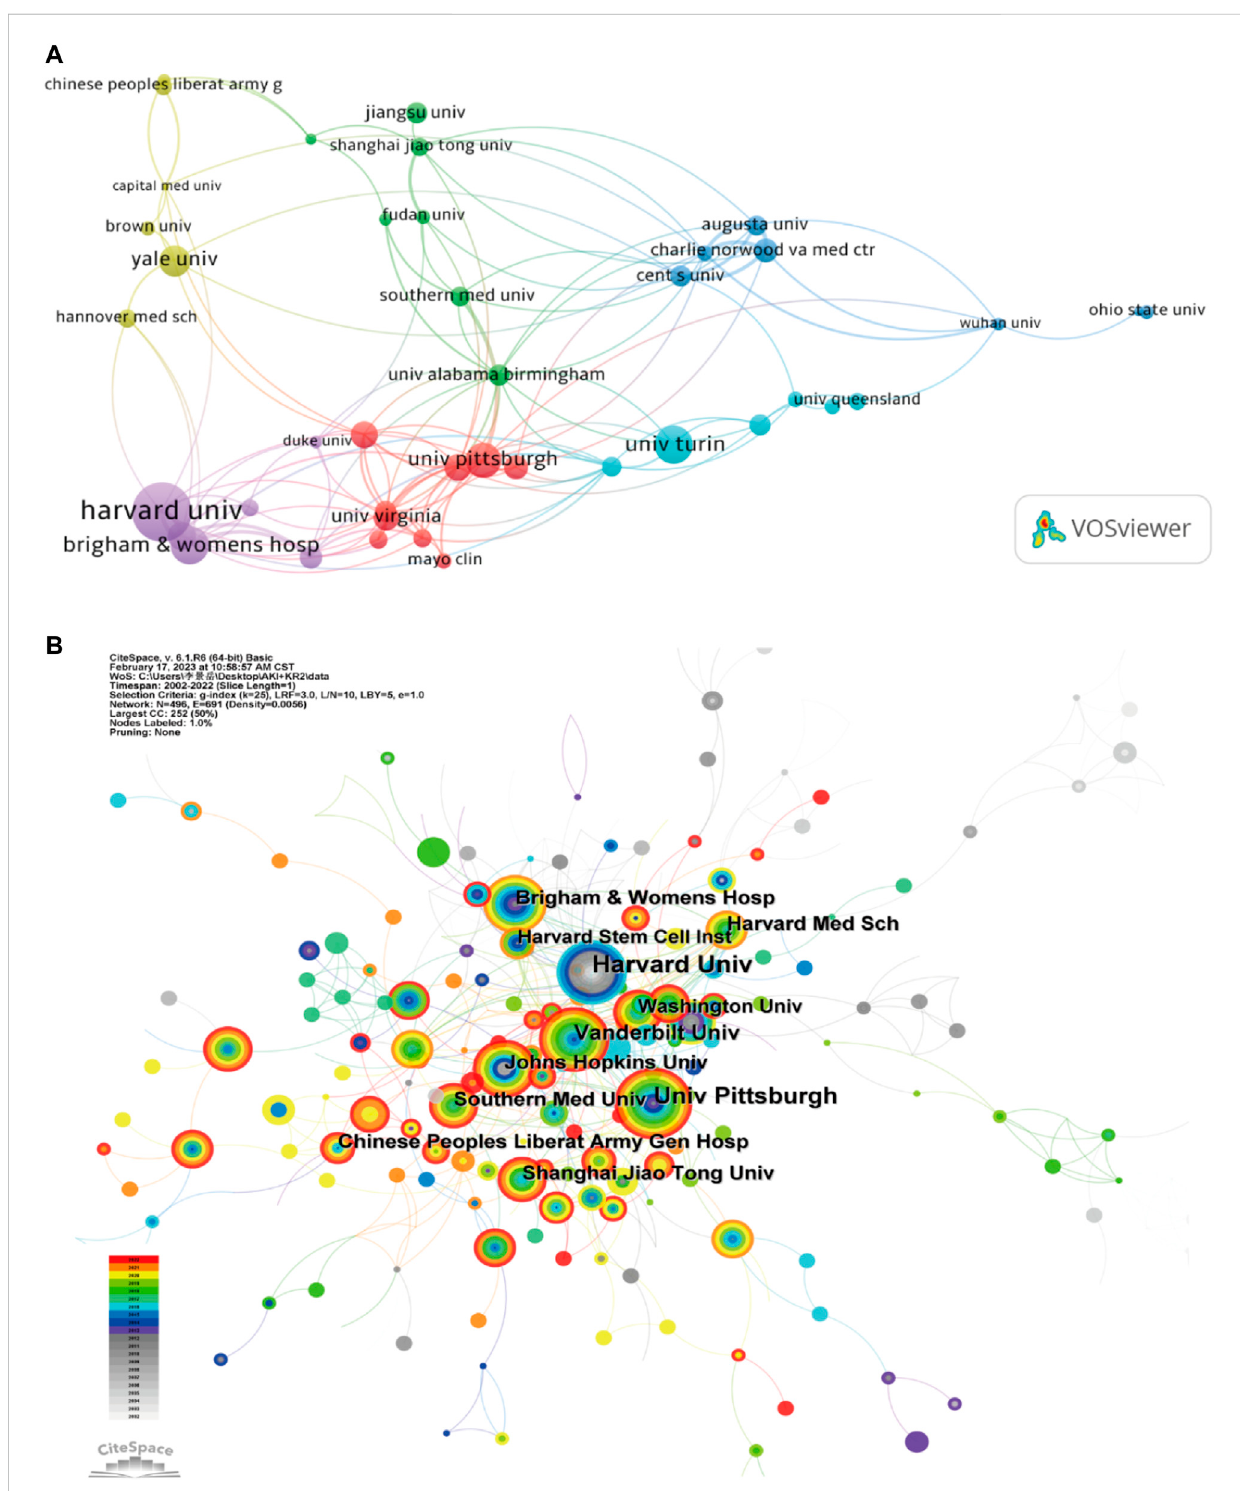
FIGURE 3 (A) Institutional cooperation diagram based on VOSviewer. (B) Institutional citation network generated by